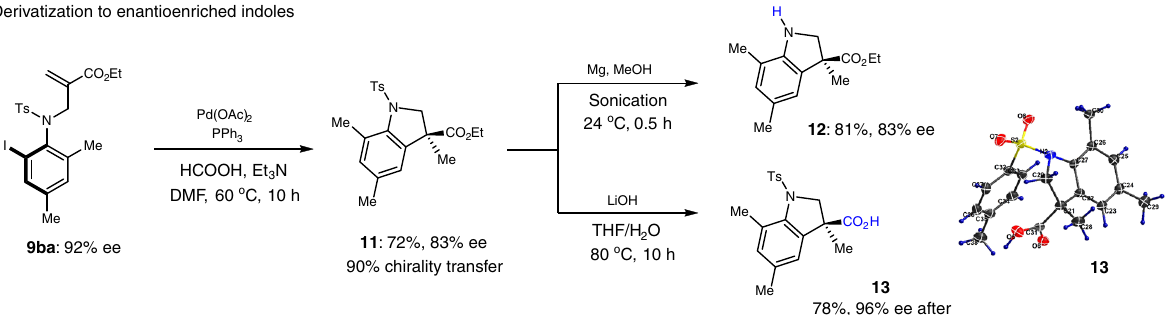
Fig. 5 Scope of axially chiral sulfonamides and derivatization to enantioenriched indolines. a Scope of sulfonamides accessible using our method. b Access to indoles with retention of